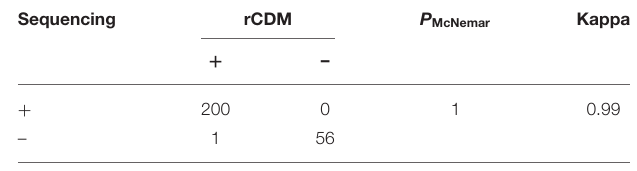
TABLE 3 | Comparison of rCDM, mCIM, and sCIM for selected strains. Strain ( n )